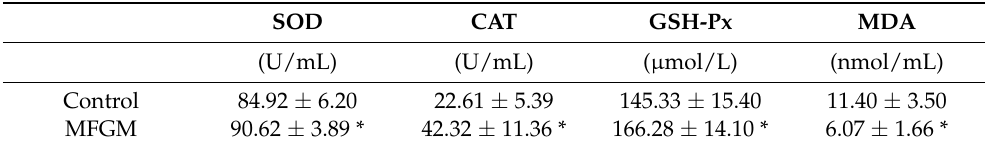
Table 2. Effects of milk fat globule membrane on antioxidant indices in the blood serum of the mice at 18